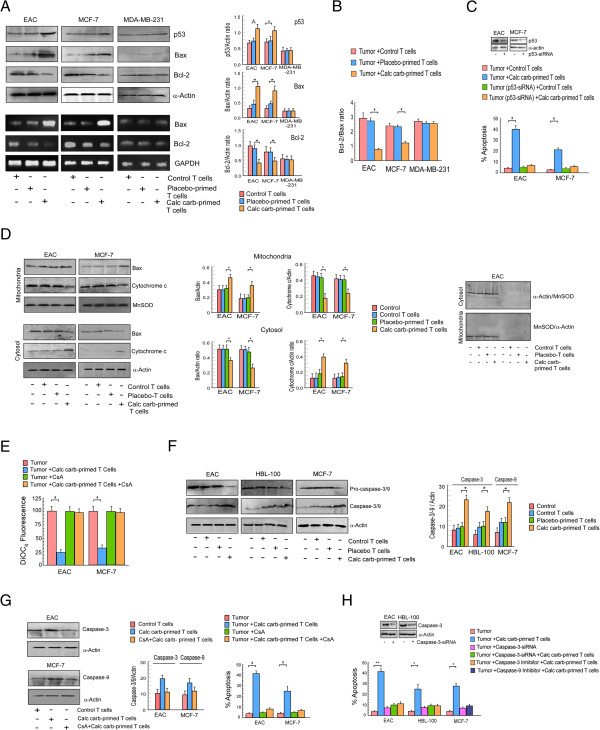
Calcarea carbonica triggers T cell-mediated tumor killing via p53-Bax-caspase-3 cascade. (A) EAC, MCF-7 and MDA-MB-231 cells were co-cultured with untreated-/placebo-/calcarea carbonica-primed T cells and subjected to Western blot/RT-PCR analysis to determine the expression profile of p53/Bax/Bcl-2 at protein and Bax/Bcl-2 at mRNA levels (left panels). Right panels represent quantitative data for Western blot. (B) Graphical representation of Bcl-2/Bax protein ratio in tumor cells co-cultured with calcarea carbonica-primed T cells. (C) Wild-type p53-expressing cells were transfected with p53-siRNA (inset) and scored for percent apoptosis when co-cultured with calcarea carbonica-primed T cells. (D) Bax and cytochrome c levels were determined in cytosolic and mitochondrial fractions of tumor cells co-cultured with placebo-/calcarea carbonica-primed T cells by Western blot analysis (left panels). Middle panels represent quantitative data. α-Actin and MnSOD were used as internal protein markers (right panels). (E) Graphical representation of mitochondrial trans-membrane potential of tumor cells co-cultured with calcarea carbonica-primed T cells pre-treated with cyclosporine-A. (F) Expression profiles of pro-/active- forms of caspase-3 in EAC and HBL-100 cells and pro-/active caspase-9 in caspase-3-null MCF-7 cells co-cultured with calcarea carbonica-primed T cells. Right panels represent quantitative data. (G) Expression profiles of active caspase-3 in EAC and caspase-9 in MCF-7 cells co-cultured with calcarea carbonica-primed T cells pre-treated with cyclosporine-A (left panel). Middle panel represent quantitative data. In parallel set, cells were scored for percentage apoptosis (right panel). (H) Percent apoptosis of EAC and HBL-100 cells co-cultured with calcarea carbonica-primed T cells in the presence of caspase-3 inhibitor (Z-DEVD-FMK) or transfected with caspase-3-siRNA and percent apoptosis of MCF-7 cells co-cultured with calcarea carbonica-primed T cells in the presence of caspase-9 inhibitor (Z-LEHD-FMK). Values are mean ±SEM of five independent experiments. *p < 0.05 and **p < 0.001 when compared with respective placebo/drug-treated sets.